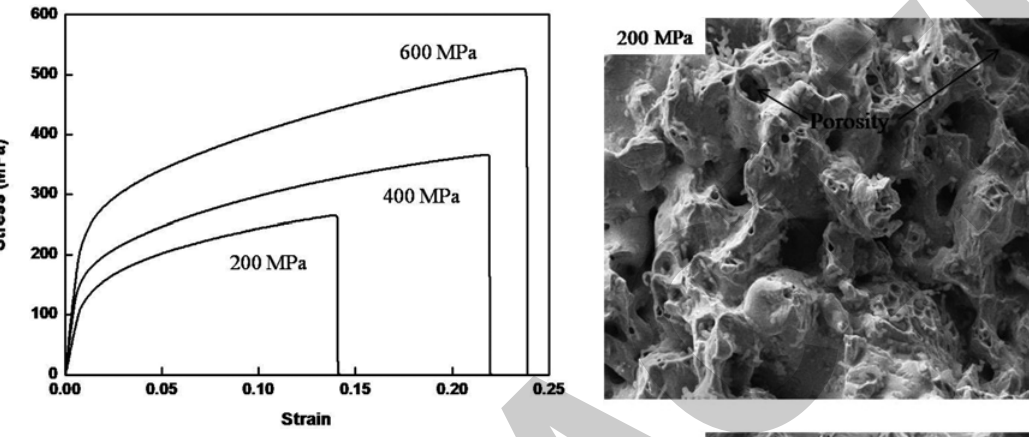
Figure 4: Stress – strain curves of the as-sintered tensile samples compacted at 200, 400 and 600 MPa and sintered at 1,400°C.